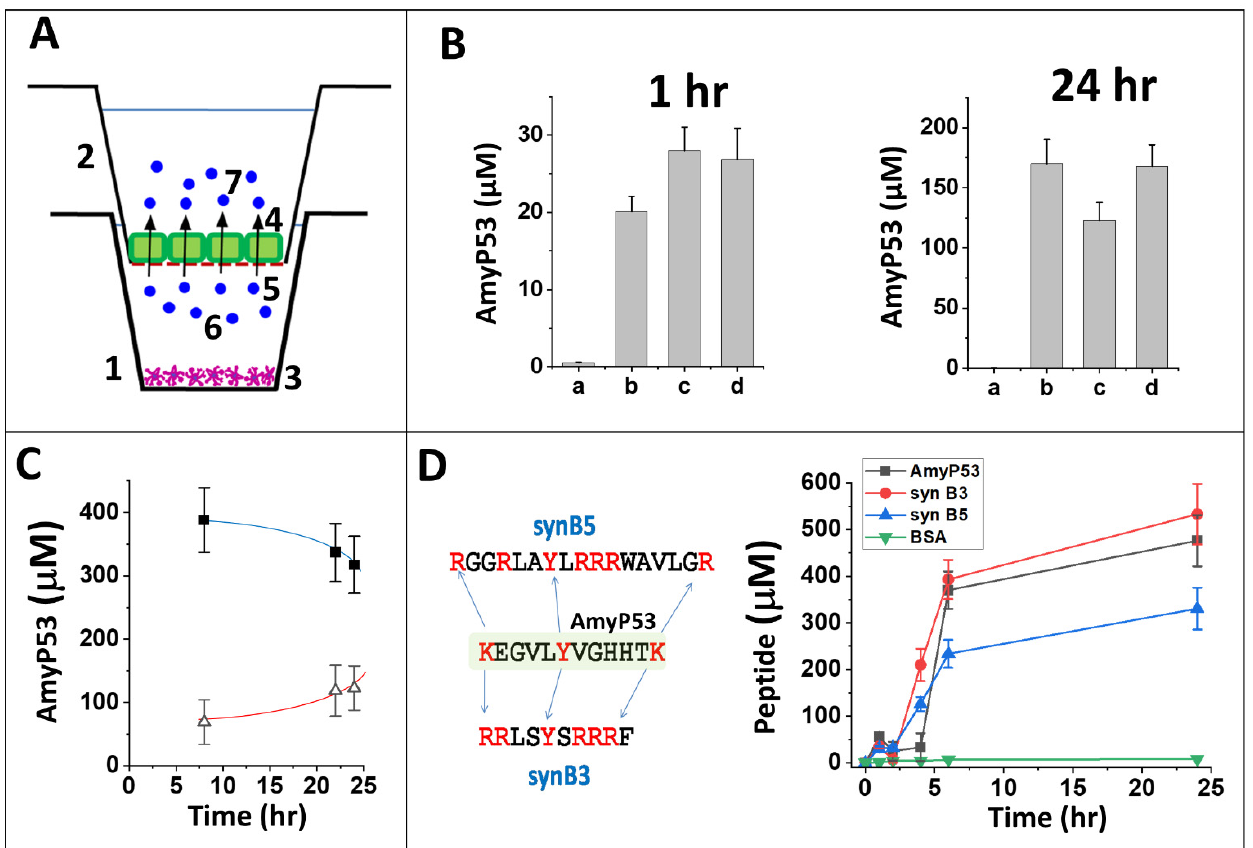
Figure 6. Passage of the AmyP53 peptide through the blood–brain barrier. ( A ) Two-compartment cell culture device. At time t0, AmyP53 is injected in the basal (donor) compartment (1), and it is progressively transported into the apical (acceptor) compartment (2). When indicated, CTX or C6 cells (3) are seeded in the basal compartment (non-contact model). The endothelial bEnd.3 cells (represented in green) (4) colonize the permeable filter (red dashed line) (5) that separates both compartments. AmyP53 molecules in the donor and acceptor compartments are respectively noted (6) and (7). ( B ) Detection of AmyP53 in the acceptor compartment after 1 h and 24 h of incubation. The cell models are bEnd.3 cells (a, b), bEnd.3/CTX (c), or bEnd.3/C6 (d). PBS (a) or AmyP53 (b, c, d) was added in the basal compartment. Data are expressed as mean ± SD (n = 6). ( C ) Simultaneous detection of AmyP53 in the donor (full squares, blue curve) and acceptor (open triangles, red curve) compartments. The data show the typical simultaneous disappearance of AmyP53 from the basal donor compartment and its progressive appearance in the apical acceptor compartment (bEnd.3/C6 model). ( D ) Comparison of AmyP53 transendothelial transport (black symbols) with two cargo peptides (synB3, red symbols, and synB5, blue symbols) and bovine serum albumin (BSA, green symbols) (bEnd.3/C6 model) in a typical experiment. The amino acid sequence of AmyP53 vs. syn B3 and syn B5 is shown in the left panel. Data are expressed as mean ± SD (n = 6).